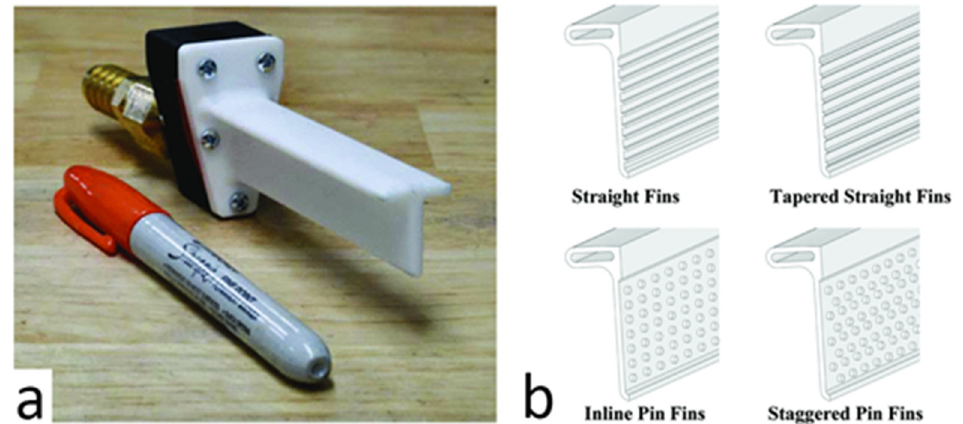
Figure 15. Additively manufactured ceramic heat exchanger for cooling the windings ( a ) and the different types of internal micro-features tested ( b ) Reprinted with permission from Ref. [43].